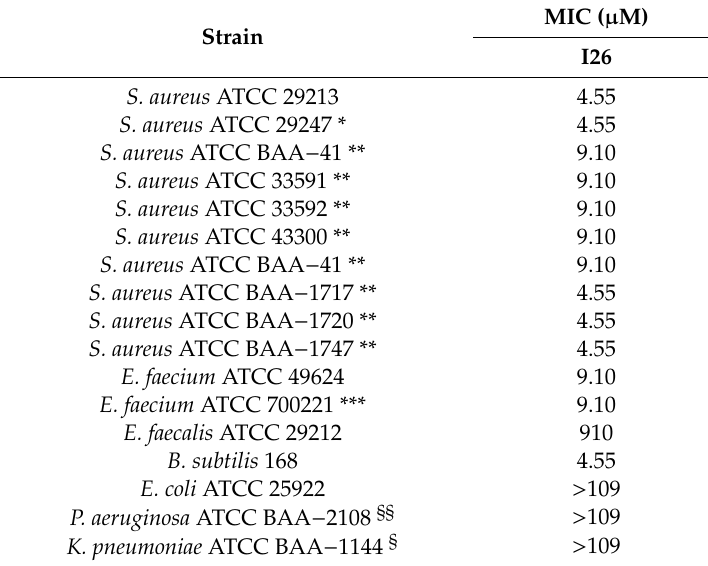
Figure 10. Tiplaxtinin. Table 10. MICs of Tiplaxtinin (I26).